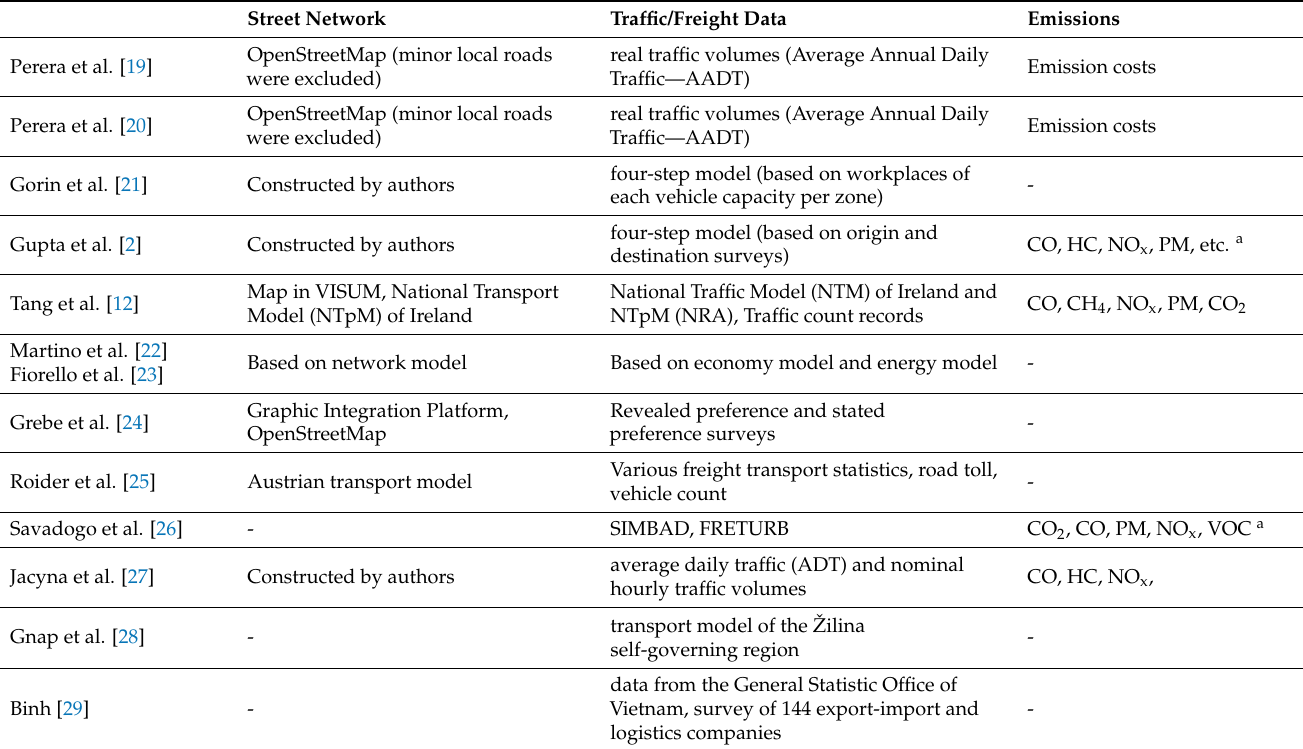
Table 1. Studies simulating freight transport in PTV